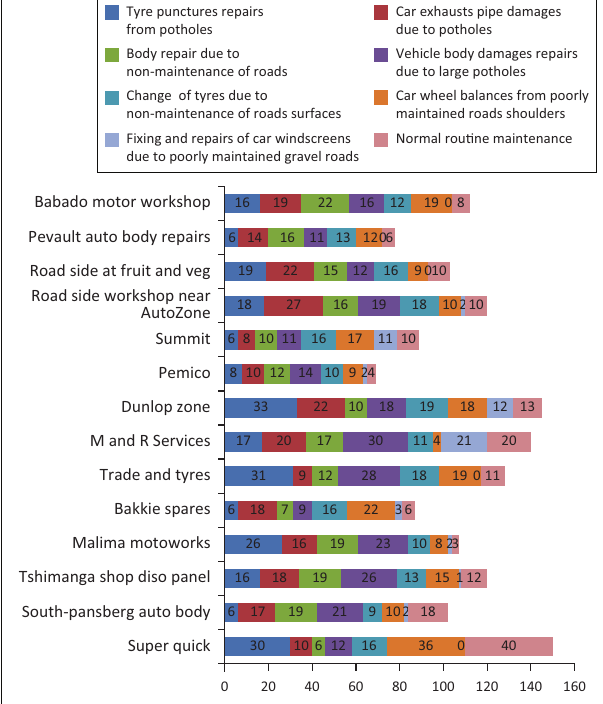
FIGURE 4: Monthly % vehicle repairs with respect to road conditions in Louis Trichardt